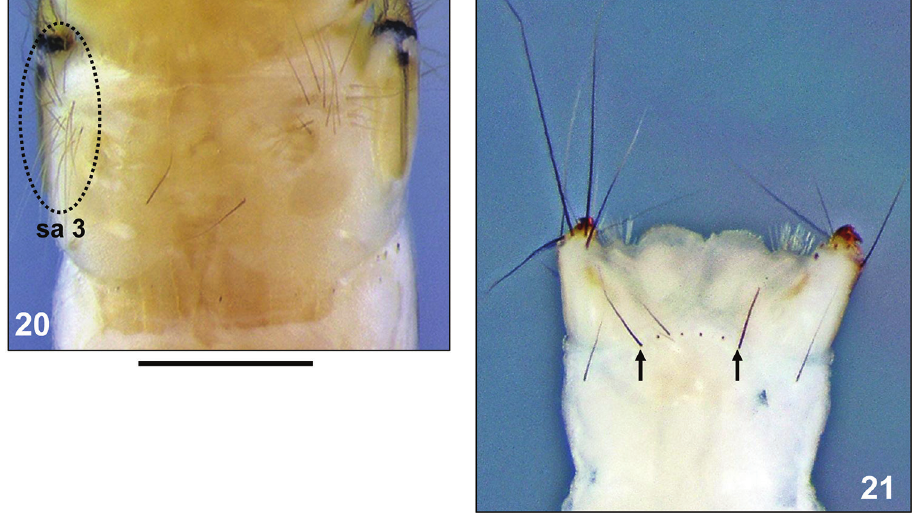
Figure 20–21. 20 Adicella reducta (McLachlan, 1865), final instar larva. Metanotum, dorsal view (sa3 = setal area 3) 21 Adicella cremisa Malicky, 1972, final instar larva. Tip of abdomen, dorsal (four setae are missing and only their alveolae visible). Scale bars: 0.5